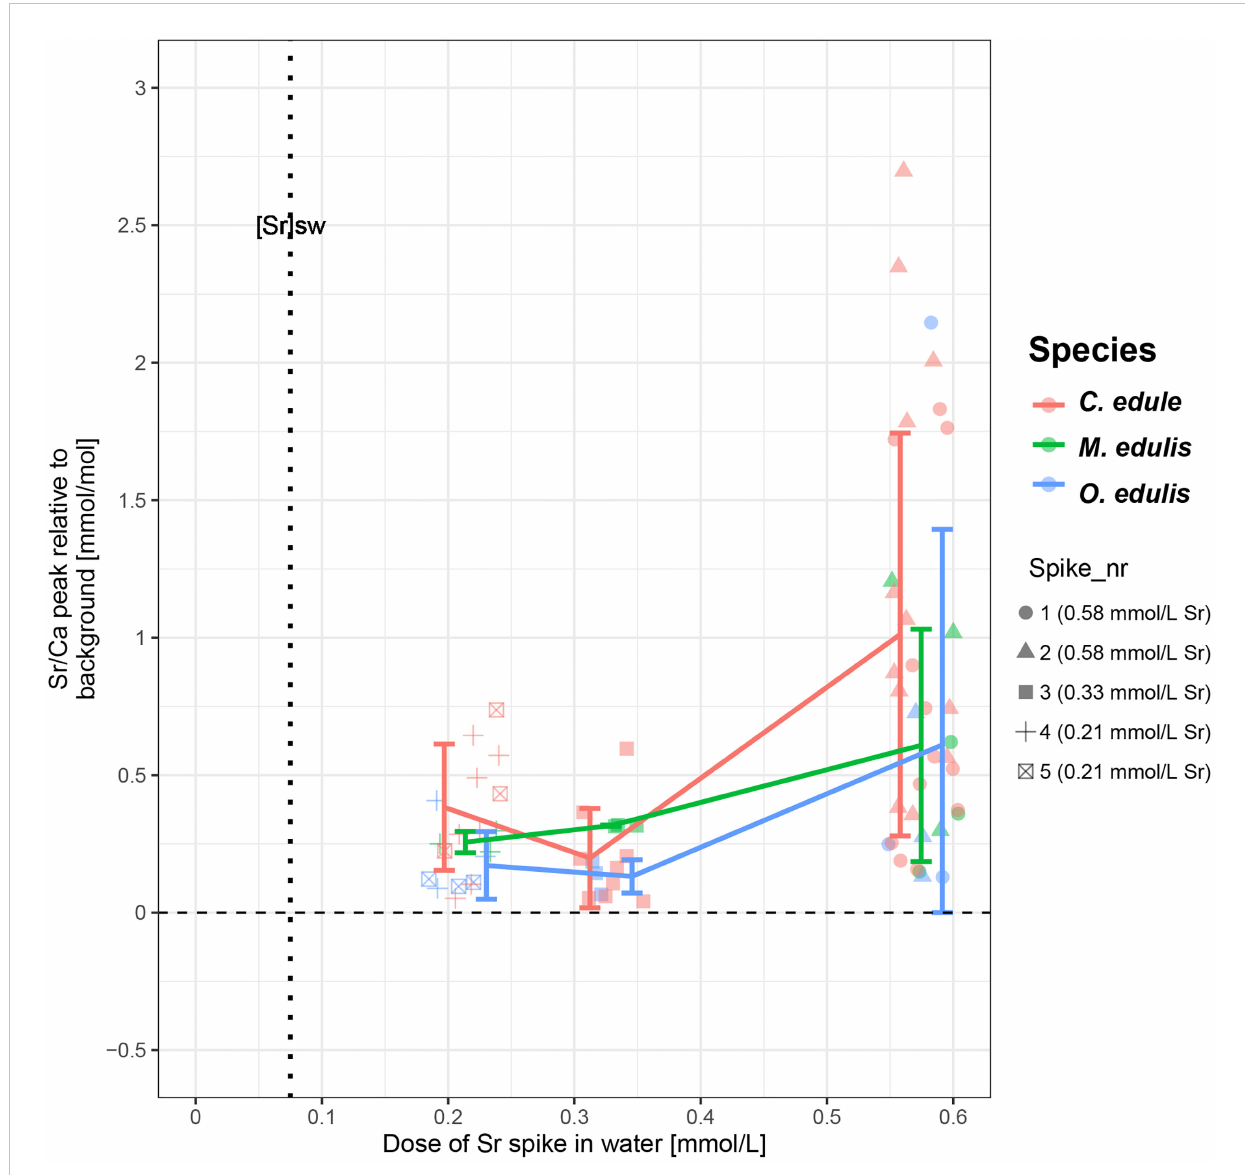
FIGURE 6 Plot showing the height of the Sr peak (in Sr/Ca ratio) relative to the background concentration ratio against the size of the elevated Sr dose for all species. Different symbols represent Sr spikes labelled in chronological order (spike 1 = 04/04/2020, spike 5 = 14/07/2020; see Table 1). Note that symbols and error bars of different species are arti fi cially horizontally offset from each other, while the actual Sr dose was equal for all species. Detailed plots of the height of the concentration peak in other trace element plotted against spike dose are provided in